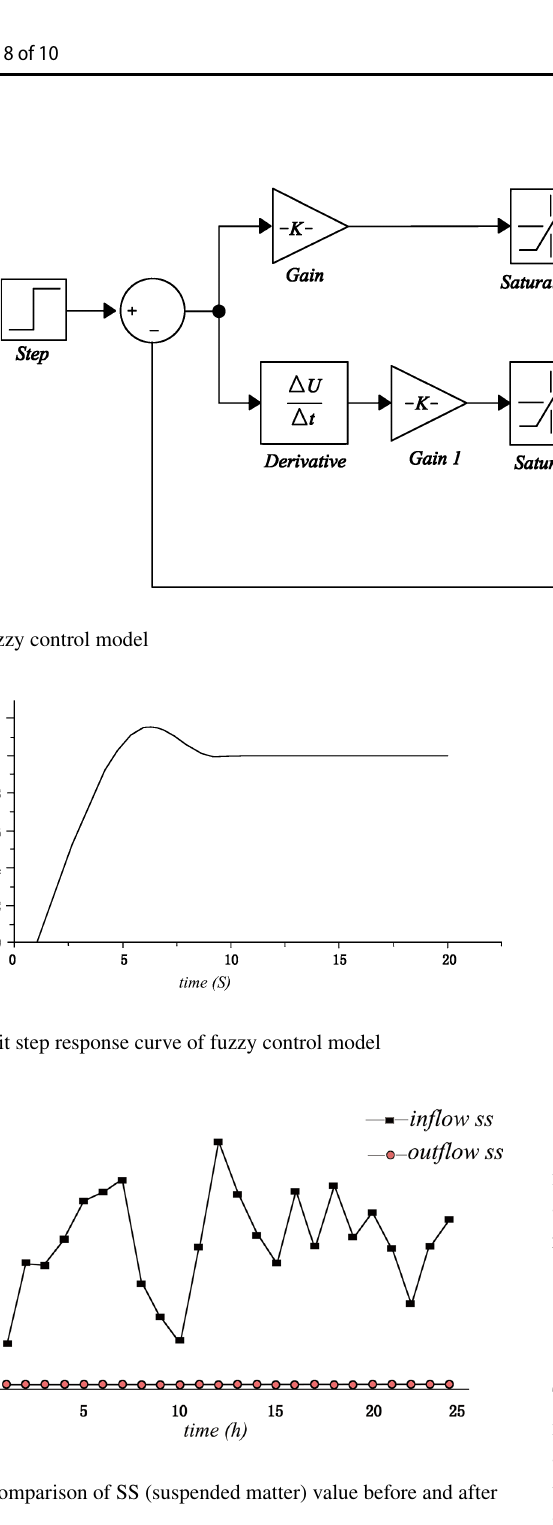
Fig. 10 Comparison of SS (suspended matter) value before and after